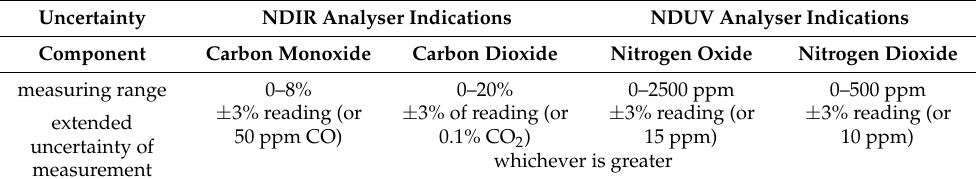
Table 3. Uncertainty of indications of measurement modules of the Semtech DS